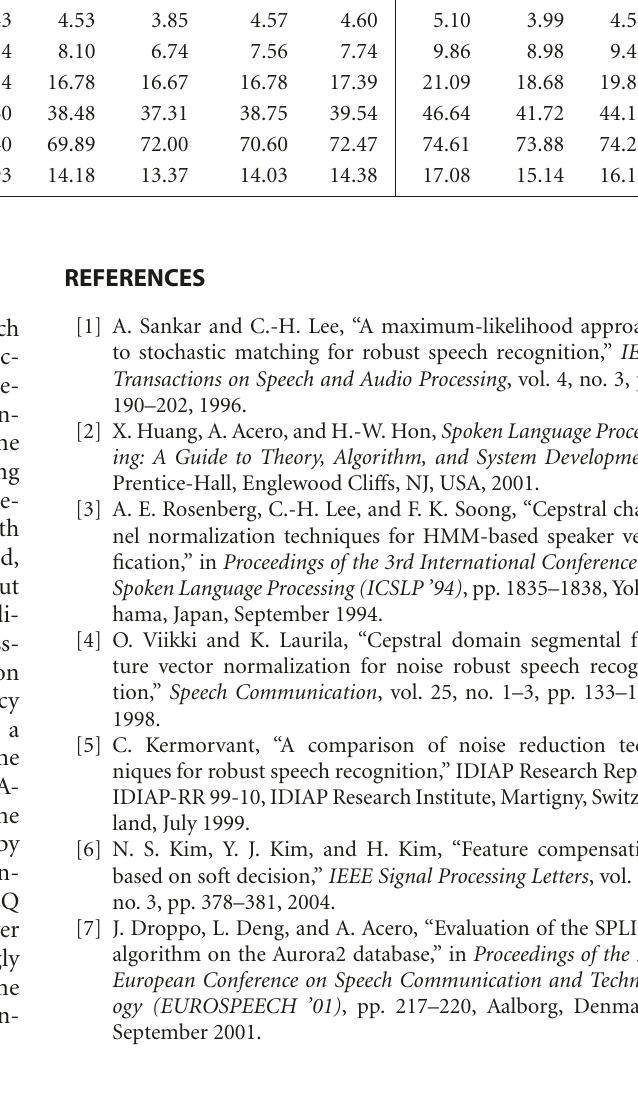
Table 7: Recognition results of the SE + CHEQ compensation technique on the Aurora 2 task under clean-condition training (WER %). Set A Set B Set SNR